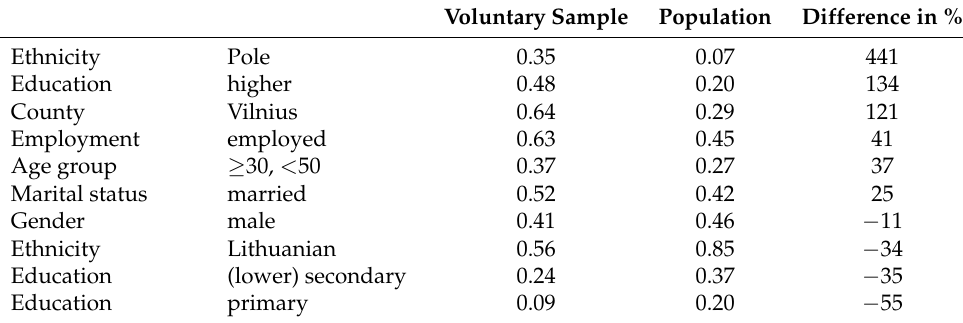
Table 1. Comparison of proportions of some sociodemographic characteristics in the voluntary sample and the whole population.